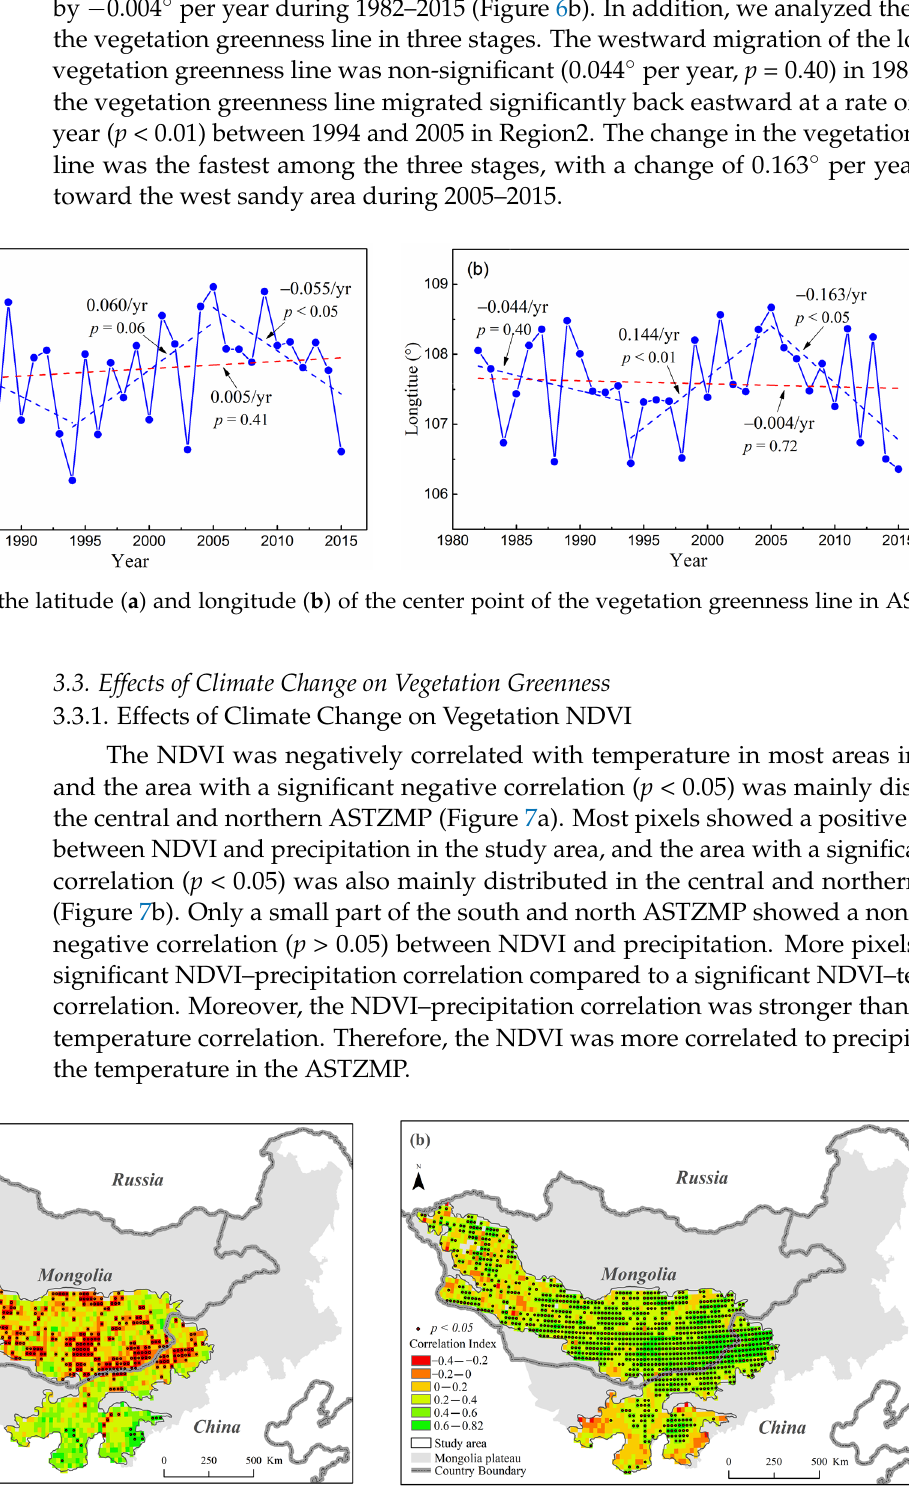
Figure 7. Spatial distribution of the correlation coefficient of NDVI with temperature ( a ) and precipitation ( b ), respectively. The stippling indicates significant correlation ( p <